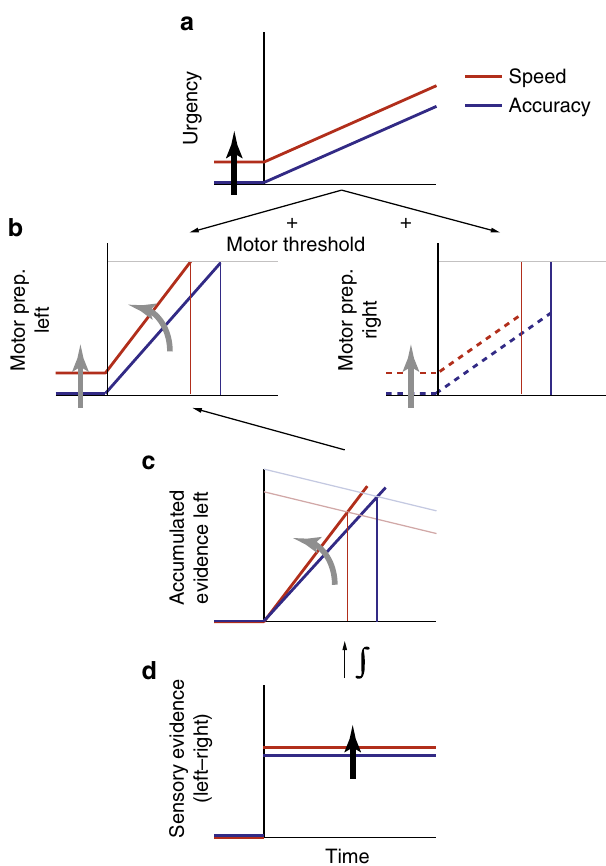
Fig. 5 Schematic summary of speed pressure effects. The schematic illustrates idealized dynamics at all cortical sensorimotor levels for a typical single trial (left-tilted, correct) in each Regime (Speed in red, Accuracy in blue), representing the primary, active speed pressure adjustments by thick black arrows, and their knock-on impact at other levels by thick gray arrows. In our proposed architecture, neural sensory evidence signals ( d , re fl ected by the SSVEP) are temporally integrated at an intermediate, motor-independent level ( c , re fl ected by the CPP), which in turn feeds into the motor-level signal representing preparation for the alternative favored by the evidence ( b , “ left ” alternative in this example). At the motor level ( b , re fl ected by Mu/Beta activity), this favored alternative races against the unfavored alternative ( b , right), with the fi rst one to cross the motor threshold determining the response choice and timing for that trial. An evidence-independent urgency signal ( a ) additively feeds both motor-level alternatives equally, and grows dynamically over time. Speed pressure has two direct effects: an enhancement of differential evidence represented at the sensory level ( d ; red trace elevated over blue trace), and an upward shift in the urgency component applied at the motor level ( a ; similar rate of increase assumed based on similar conditional accuracy decline, Fig. 1c).